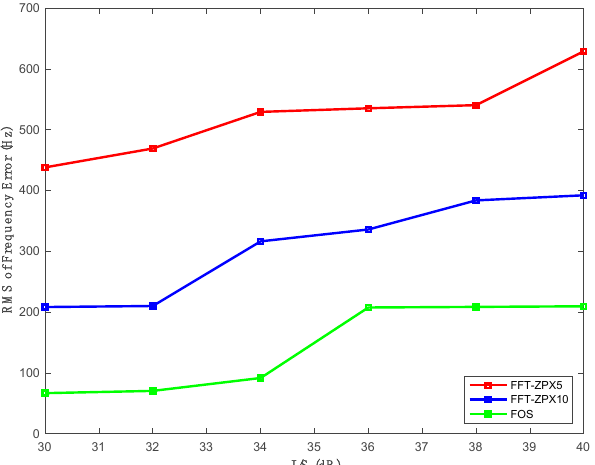
Figure 11. RMS of frequency errors vs. different J/S using the proposed method and the other two methods.